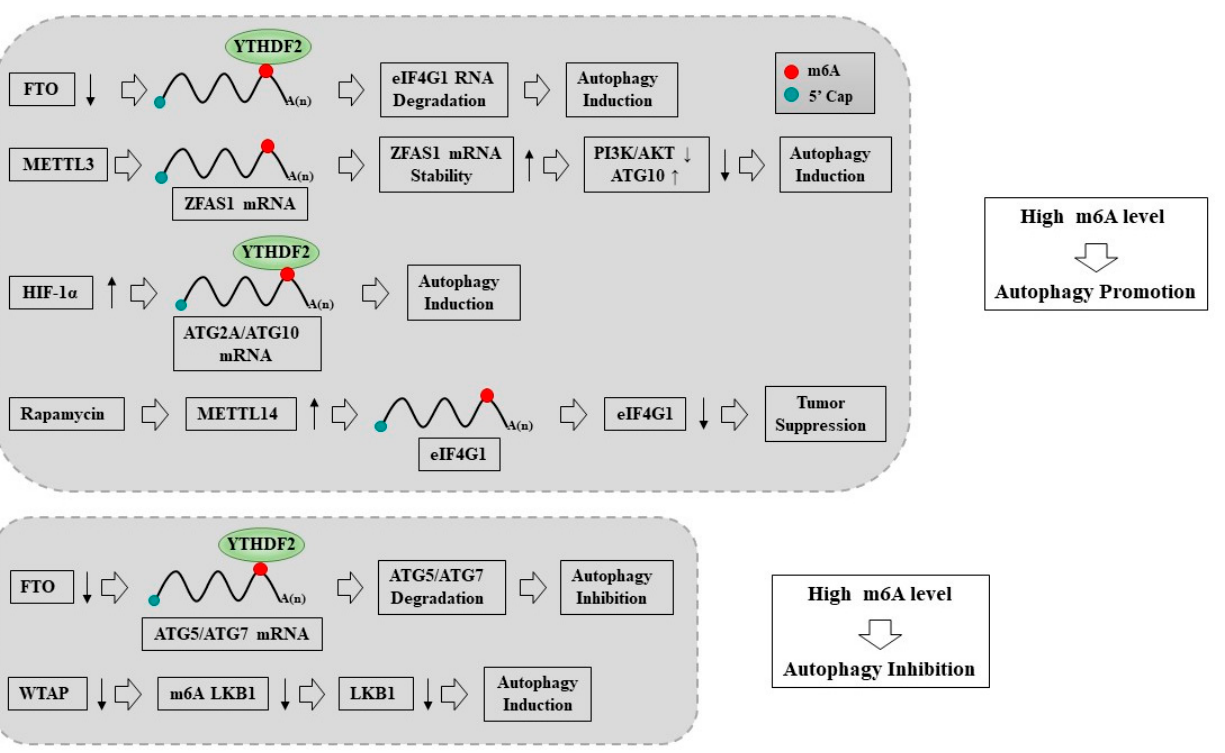
Figure 2. High m6A levels regulate autophagy in a context dependent manner. High levels of m6A promote autophagy (upper panel). High levels of m6A can be induced by METTL3, HIF-1 α , METTL14, or downregulation of FTO (upper panel). High levels of m6A inhibit autophagy (lower panel). ↓ denotes decreased expression/activity. ↑ denotes positive regulation. Hollow arrows denote direction of reaction. → denotes direction of reaction.